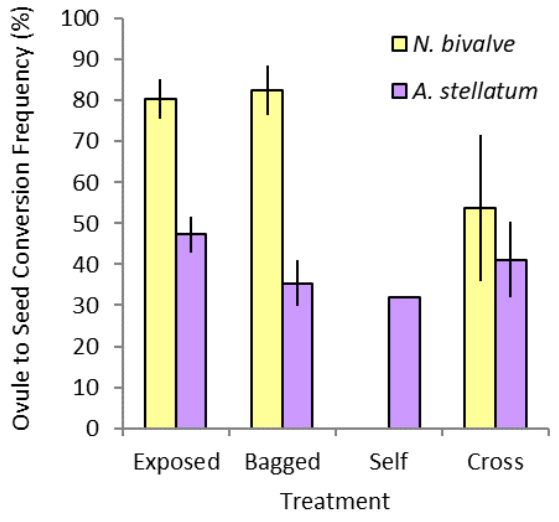
F IGURE 11. Mean percentages of seed per ovule per flower of N. bivalve (N = 4-24) and A. stellatum (N = 1-22). Error bars are standard error of the mean persimilis on N. bivalve. Augochlorella aurata, A. persmilis, and Ceratina calcarata were shared by N. bivalve and